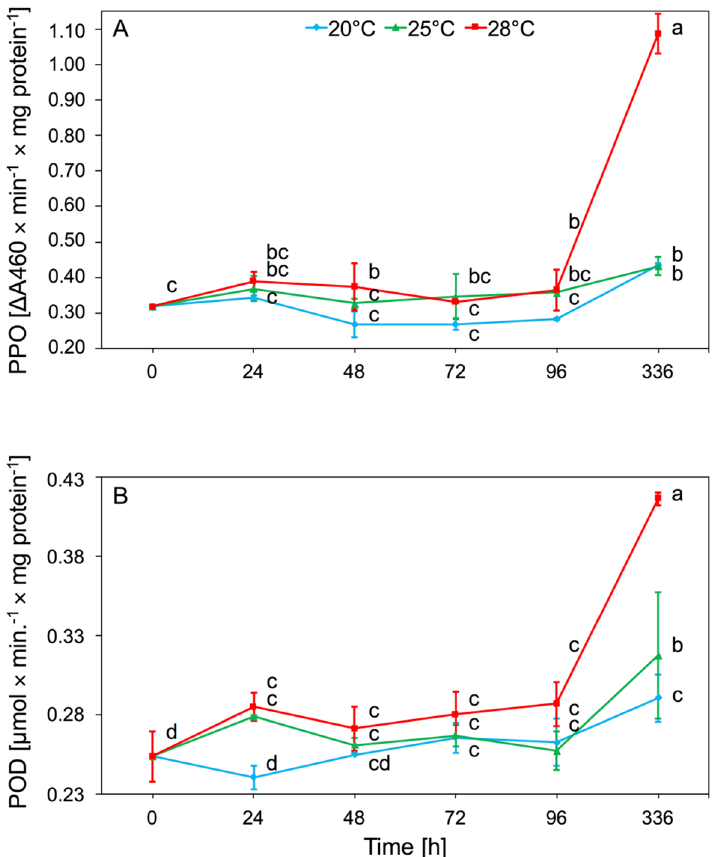
Figure 3. Activity change of polyphenol oxidase (PPO) ( A ) and peroxidase (POD) ( B ) in the tissues of A. pomi at temperature 20, 25, and 28 °C (mean ± SE; control = aphids at 20 °C). Values not followed